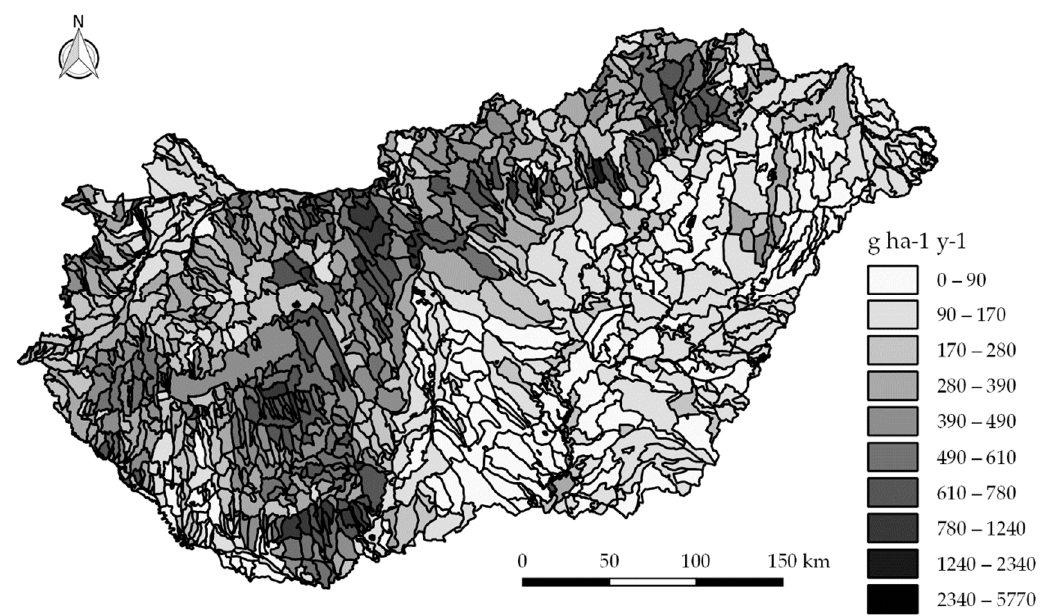
Figure 11. Di ff use-source area-specific TP emissions (sums of all Figure 11. Diffuse-source area-specific TP emissions (sums of all pathways).